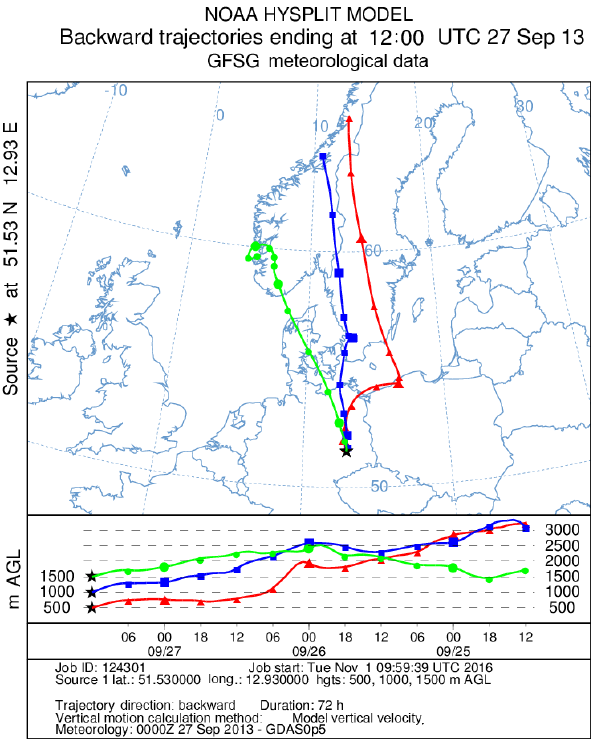
Figure 5. Three 72h backward trajectories for 500 (red), 1000 (blue), and 1500m (green) aboveground for Melpitz, ending at 14 September, 12:00UTC.